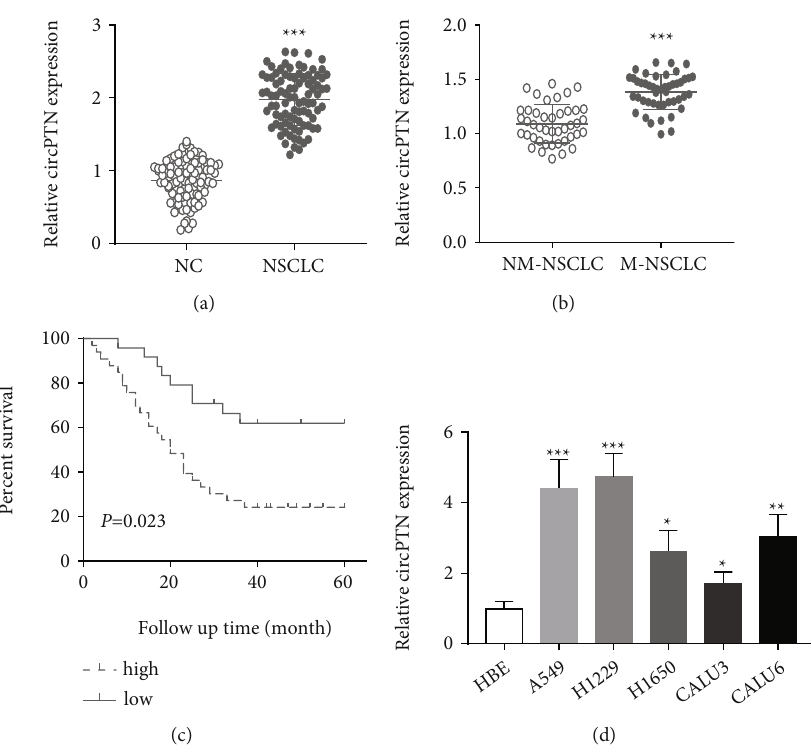
Figure 1: circPTN is highly expressed in NSCLC cells and tissues. (a) circPTN levels were analyzed in NSCLC tissue samples and para- cancerous tissues. (b) circPTN levels were analyzed in non-metastatic tumor samples and metastatic samples. (c) KM plotter analysis of circPTN expression level and the overall survival in NSCLC patients. (d) qRT-PCR was employed to detect the expression levels of circPTN in di ff erent NSCLC cell lines. * P < 0 : 05 ; ** P < 0 : 01 ; and *** P < 0 : 001